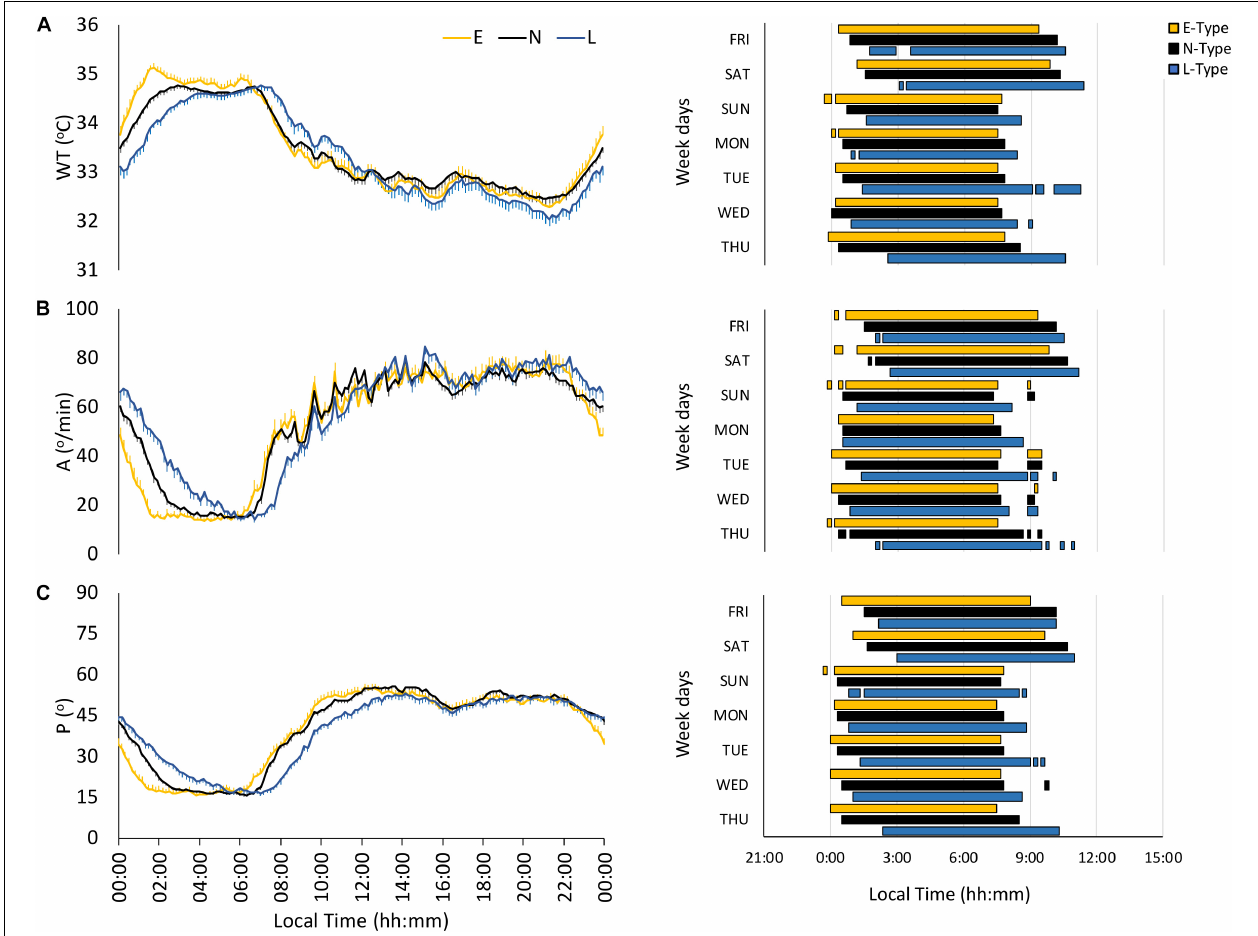
FIGURE 2 | Mean waveforms and actograms for early (E-types, in yellow; n = 20% of total subjects), neither (N-types, in dotted black; n = 60% of total subjects), and late-types (L-types, in blue; n = 20% of total subjects) for: (A) wrist temperature (WT; total subjects = 159), (B) activity (A; total subjects = 159), and (C) body position (P; total subjects = 159). Waveform data are expressed as mean ± SEM. WT actogram corresponds to the third tercile values, while activity and body position actograms correspond to the first tercile values (values corresponding to the rest